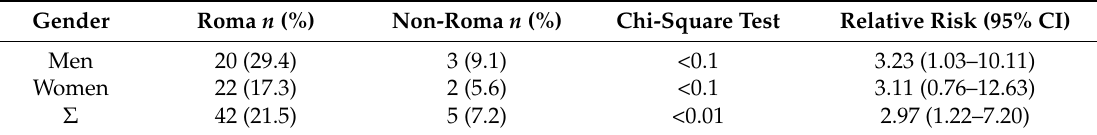
Table 2. Prevalence of Hepatitis E infection in Roma ( n = 195) and non-Roma population ( n = 69).